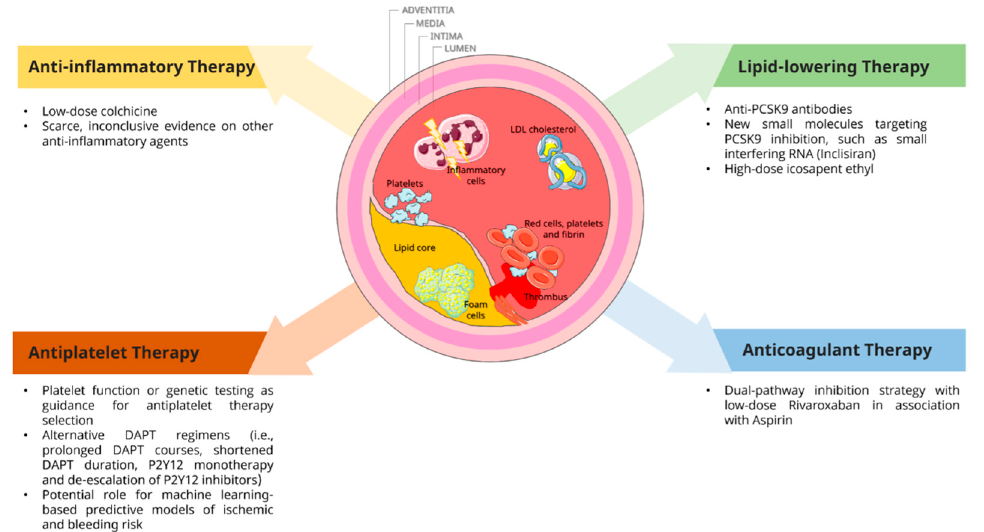
Figure 2. Therapeutic targets and medical treatment novelties in chronic coronary syndrome. Platelet aggregation, coagulation, cholesterol, and systemic inflammation all play a pivotal role in coronary artery disease progression and thus represent the targets for medical therapeutical interventions. Here represented are the recent advances in antiplatelet, anticoagulant, anti-inflammatory, and lipid-lowering medical therapy. Abbreviations: DAPT, dual anti-platelet therapy; LDL, low-density lipoprotein; PCSK9, proprotein convertase subtilisin kexin type 9.